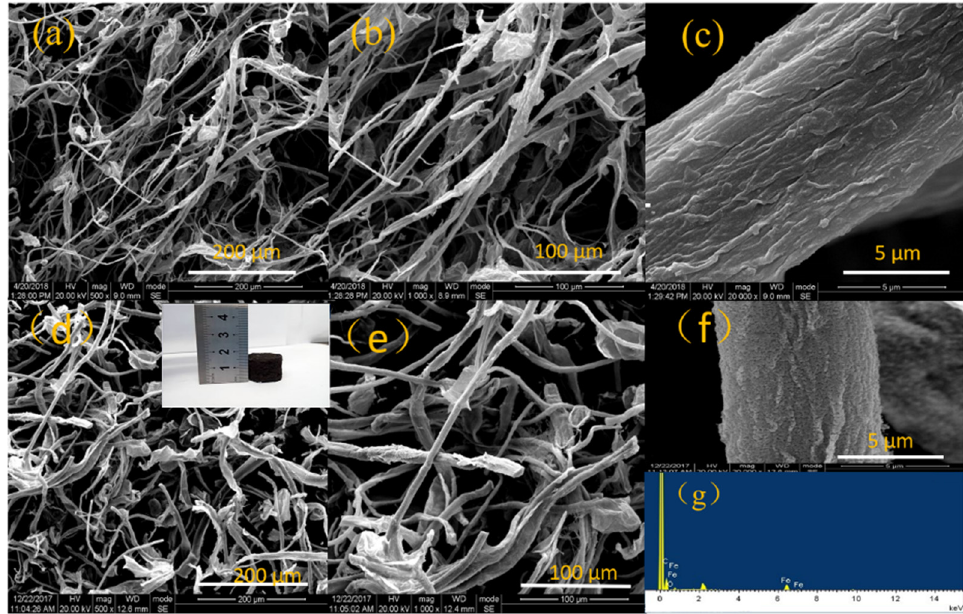
Figure 2. SEM images of the fractured surface of CA ( a – c ) and Fe/CA ( d – f ). EDS spectrum of Fe/CA ( g ). A photograph of Fe/CA is inserted in ( d ).